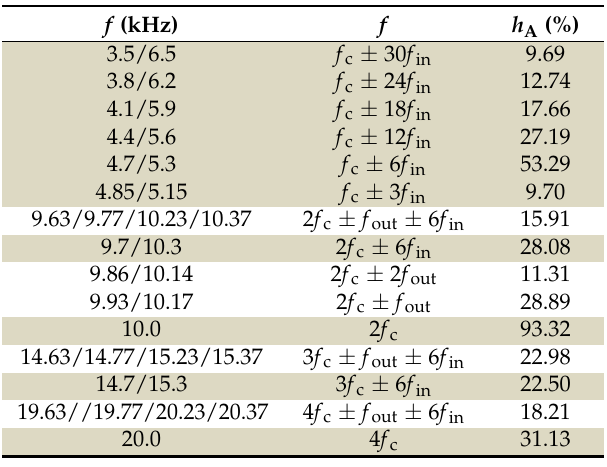
Table 5. The main harmonic components in high-frequency bands.